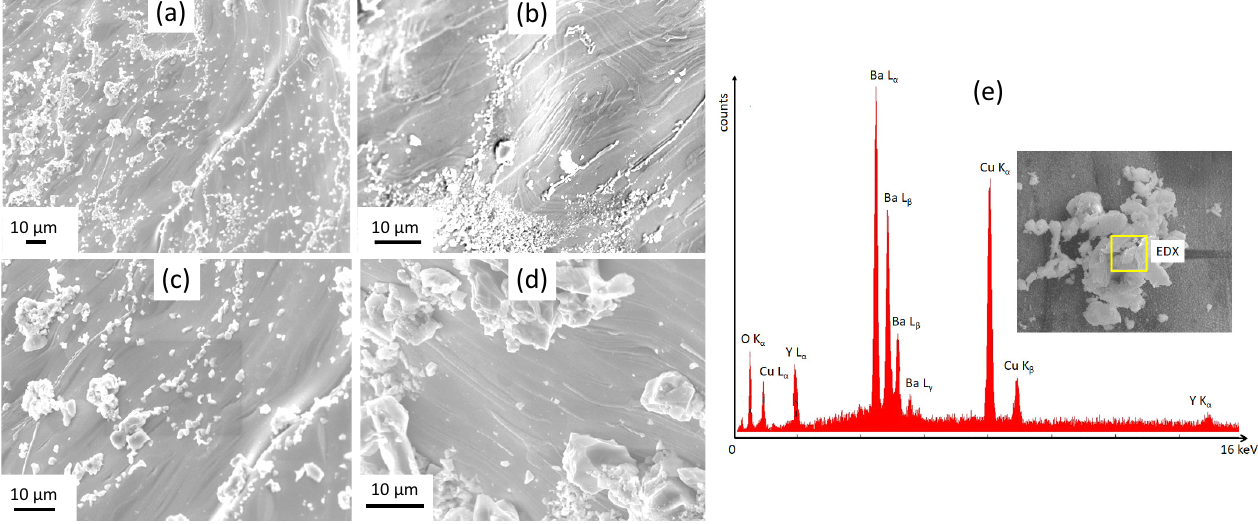
Figure 3. ( a – d ) SEM images (various magnifications ranging between 650 × and 2200 × ) showing details of the internal surfaces of the foam struts and vertices. The particles seen on the strut surfaces are Ba 3 Cu 5 O y particles as determined by EDX analysis ( e ). These structures and particles are caused by the capillary flow of the liquid phase during IG-processing, which is not seen in conventional bulk